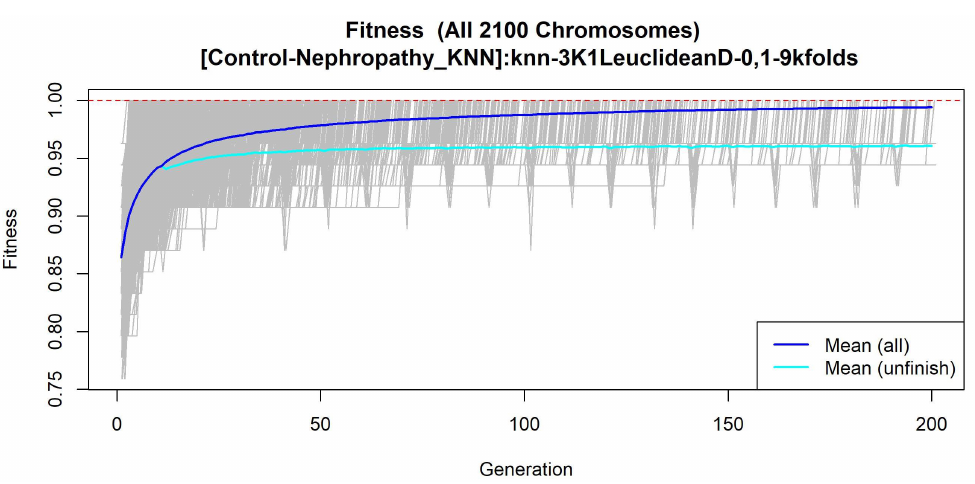
Figure 12. Gene frequency and gene rank stability in models are ascertained by applying GA with KNN to select the main features from the Control-DN dataset. ( A ) Gene frequency allows observing the number of times each feature appears in the models. ( B ) Gene rank allows observing the stability and frequency of each feature within the models and orders them by rank.